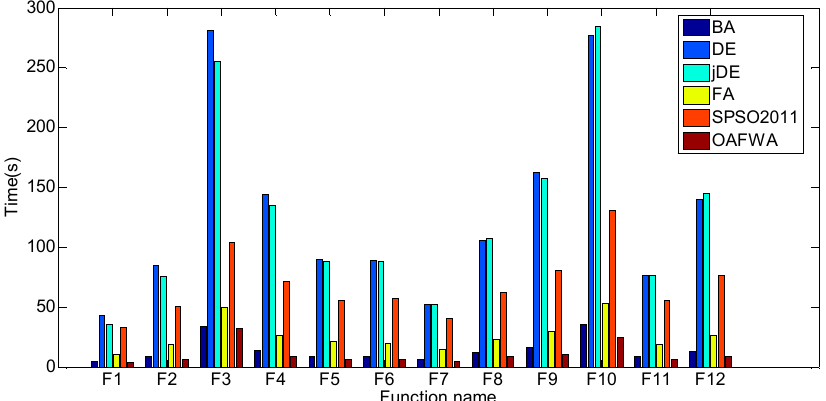
Figure 3. Runtime cost of the six algorithms for twelve functions when popSize = 20. Algorithms 2016 , 9 , 43